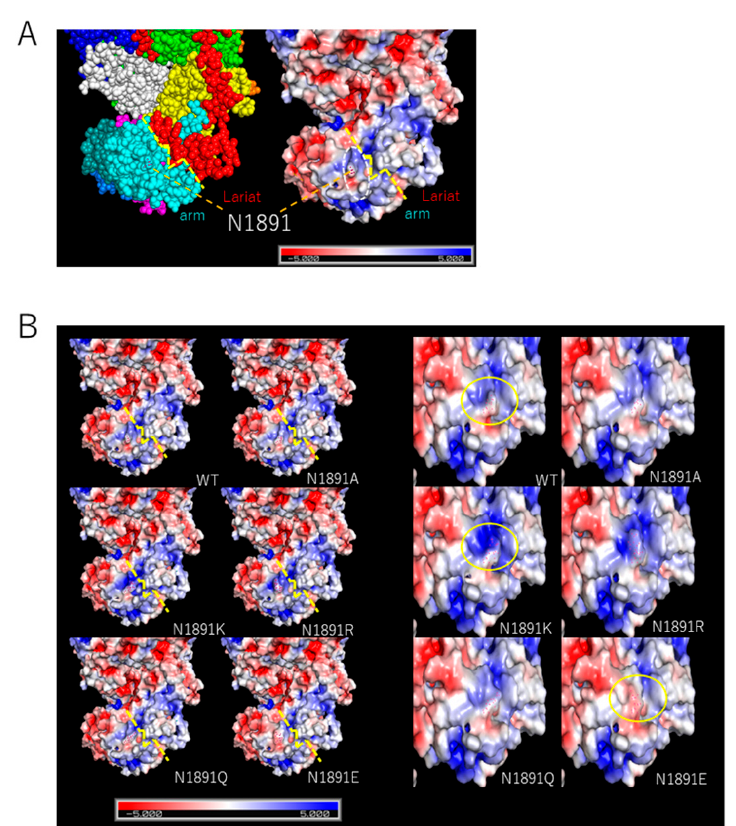
Figure 4. In silico analysis of the surface charges among the SFTSV L protein variants. ( A ) Sphere diagram (left) and surface charge diagram (right) of the SFTSV L protein. The deeper blue indicates a positive charge and the deeper red indicates a negative charge on the surface charge diagram. The border line of the arm domain and lariat domain is highlighted by a yellow dashed line. The position of N1891 is pointed at by the orange dashed line. The “edge” was indicated by a white dashed circle. ( B ) Comparison of the surface charge diagrams of the SFTSV L protein variants shown in the same angle as ( A ) (left) and in a different angle and zoomed (right). In both diagrams, the sidechain of position N1891 is shown in red dots. In the left diagrams, the border lines between the arm domain and the lariat domain are highlighted by wide yellow dashed lines. In the right diagrams, the surface charge differences around position 1891 were focused by a yellow circle. The deeper blue indicates a positive charge and the deeper red indicates a negative charge on the surface charge diagram.